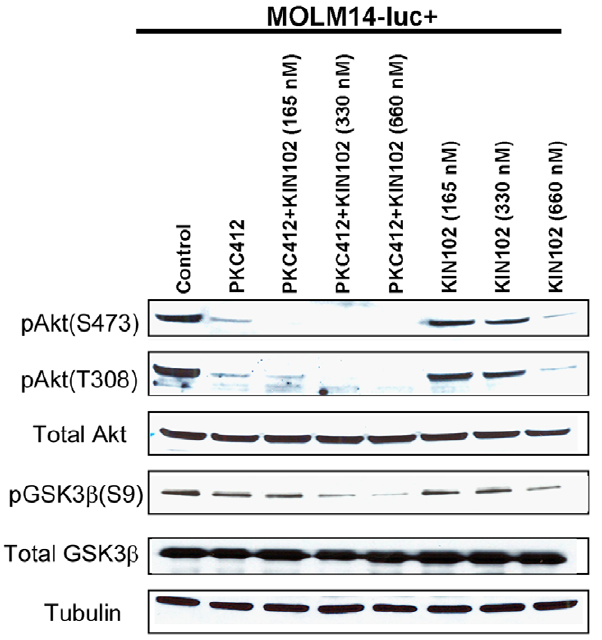
Figure 7. Phospho-Akt mediates synergy observed between allosteric Akt inhibitor, KIN001-102, and PKC412. Immunoblots of protein lysates prepared from MOLM14-luc + cells treated for 2 hours with PKC412 (40 nM), KIN001-102 (165, 330, 660 nM), or a combination of the two agents in the presence of 50% SCM. Data shown are representative of two independent experiments in which similar results were achieved.